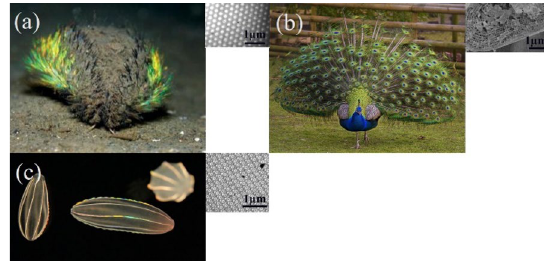
Figure 3 SEM image of a setae of sea mouse [34]; b peacock feather [36]; and c epidermal cells of melon jellyfish